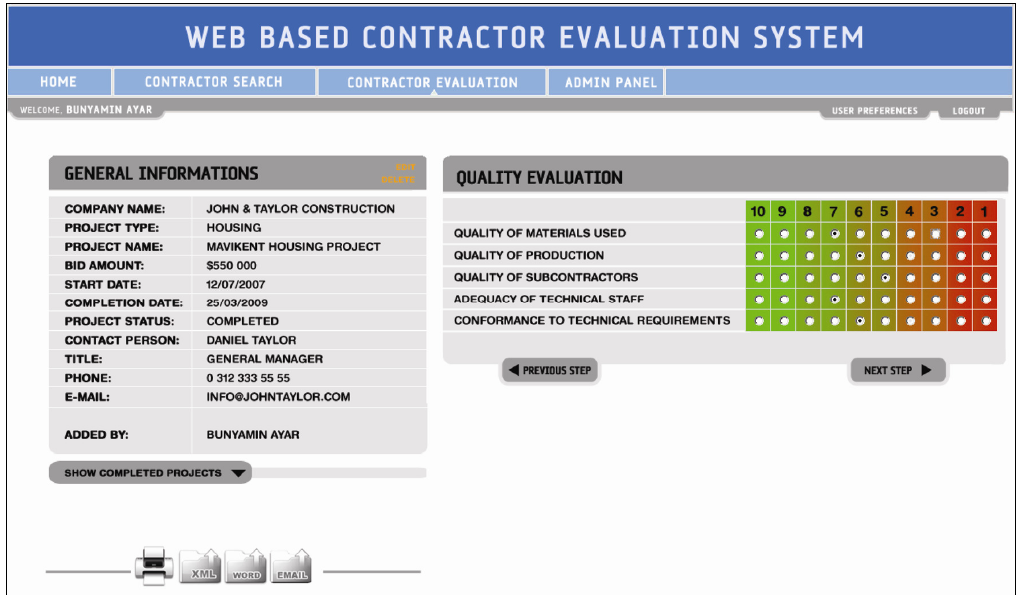
Fig. 5. An example of a GC evaluation result in WEB-CONTEST